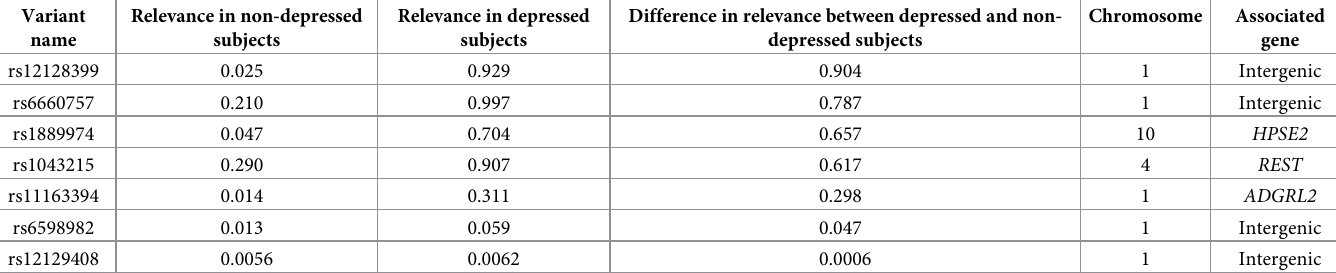
Table 4. Posterior probability of relevance of SNPs with respect to migraine in interaction with lifetime